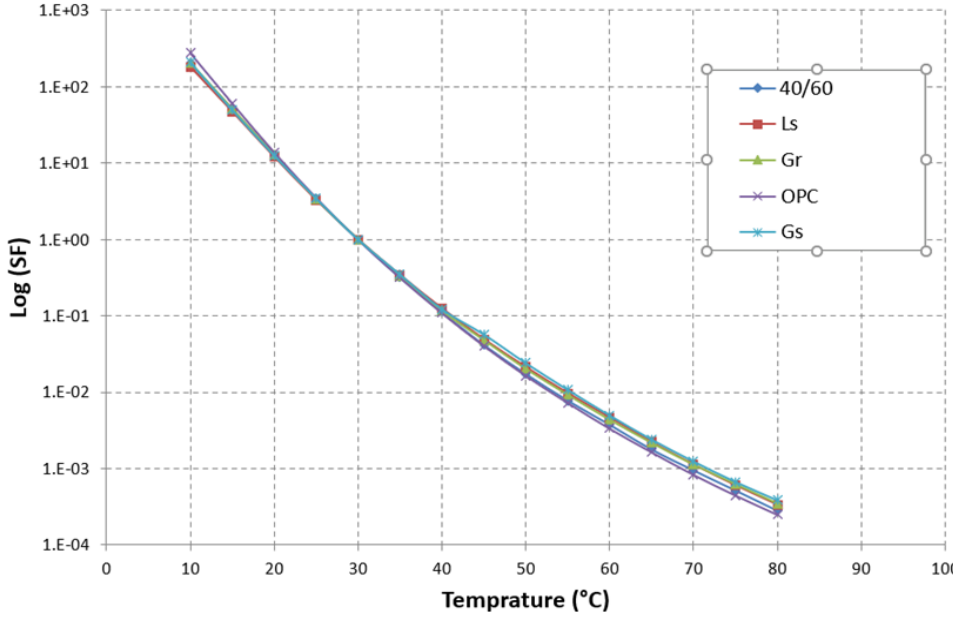
Figure 7. Shift factor plots of mastics.